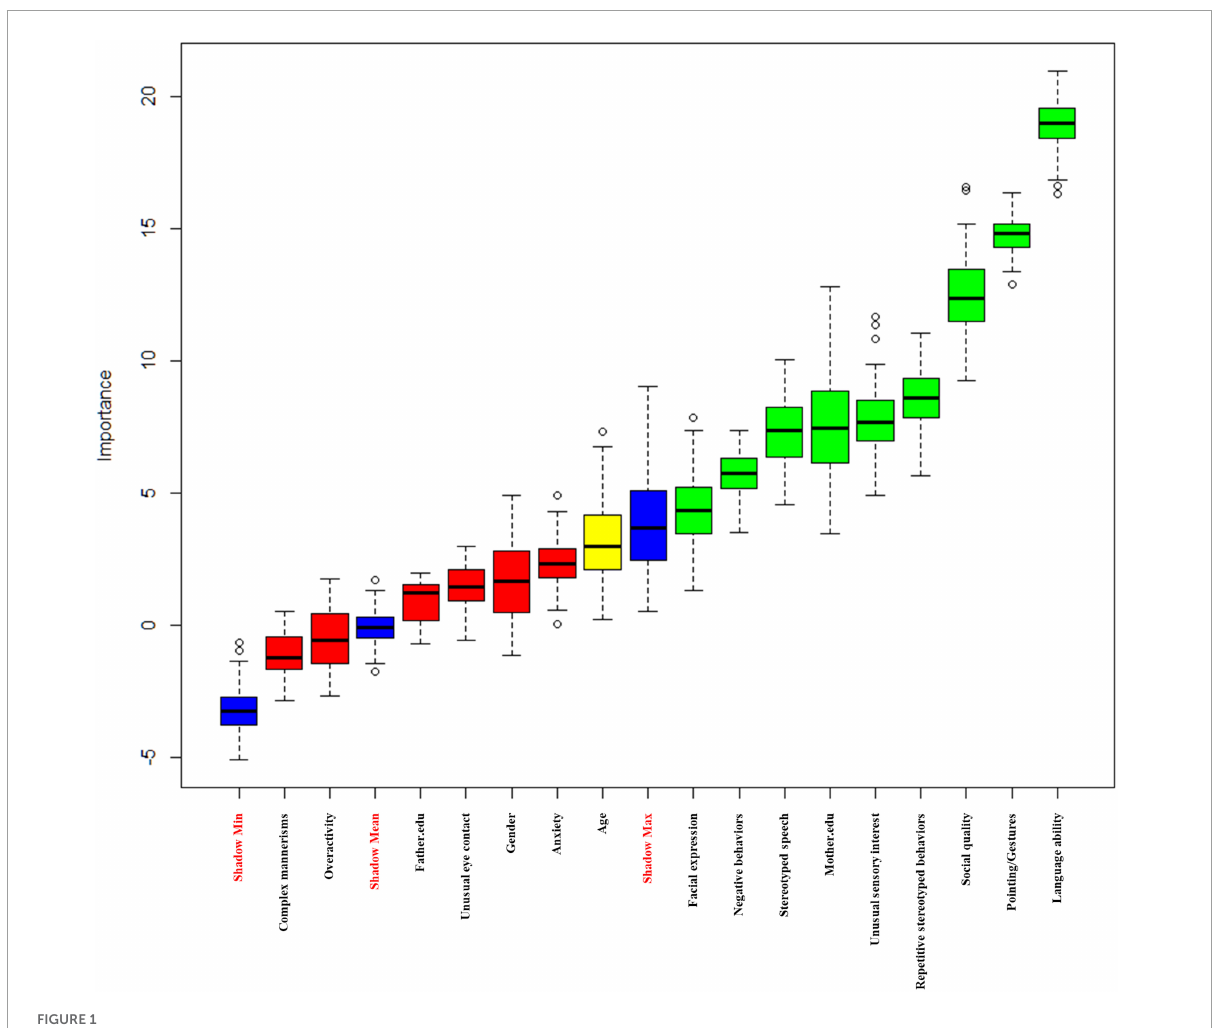
FIGURE1 Boruta-based feature selection results.